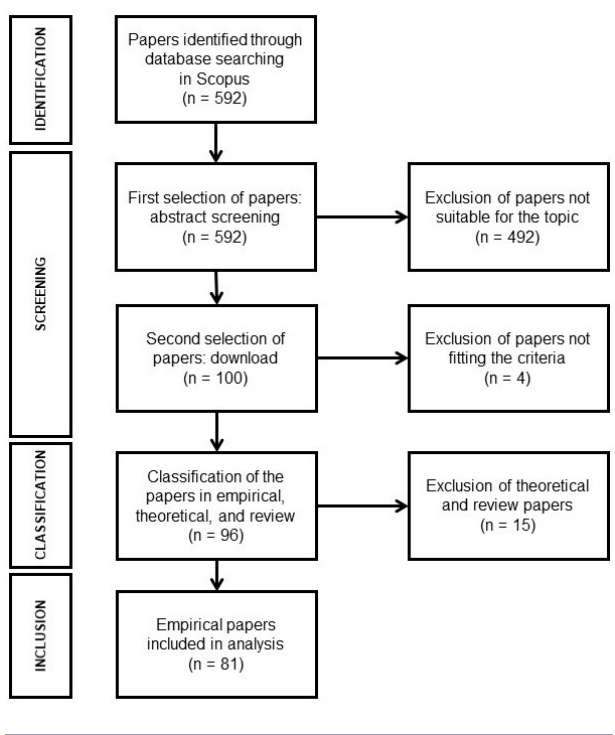
Fig. 1 . Flow diagram of the selection process used in the systematic literature